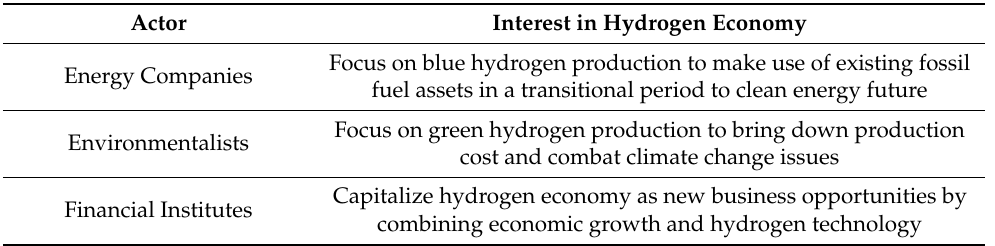
Table 2. Summary of actors and their interest in hydrogen